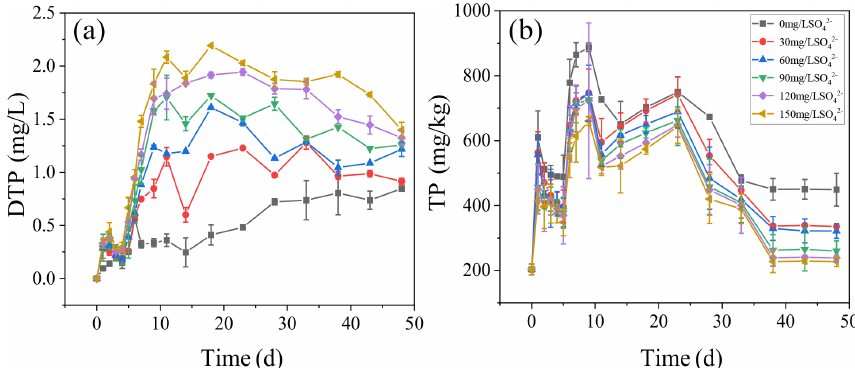
Figure 3. The concentrations of TP in the overlying water (a) and sediments (b) during the incubation.